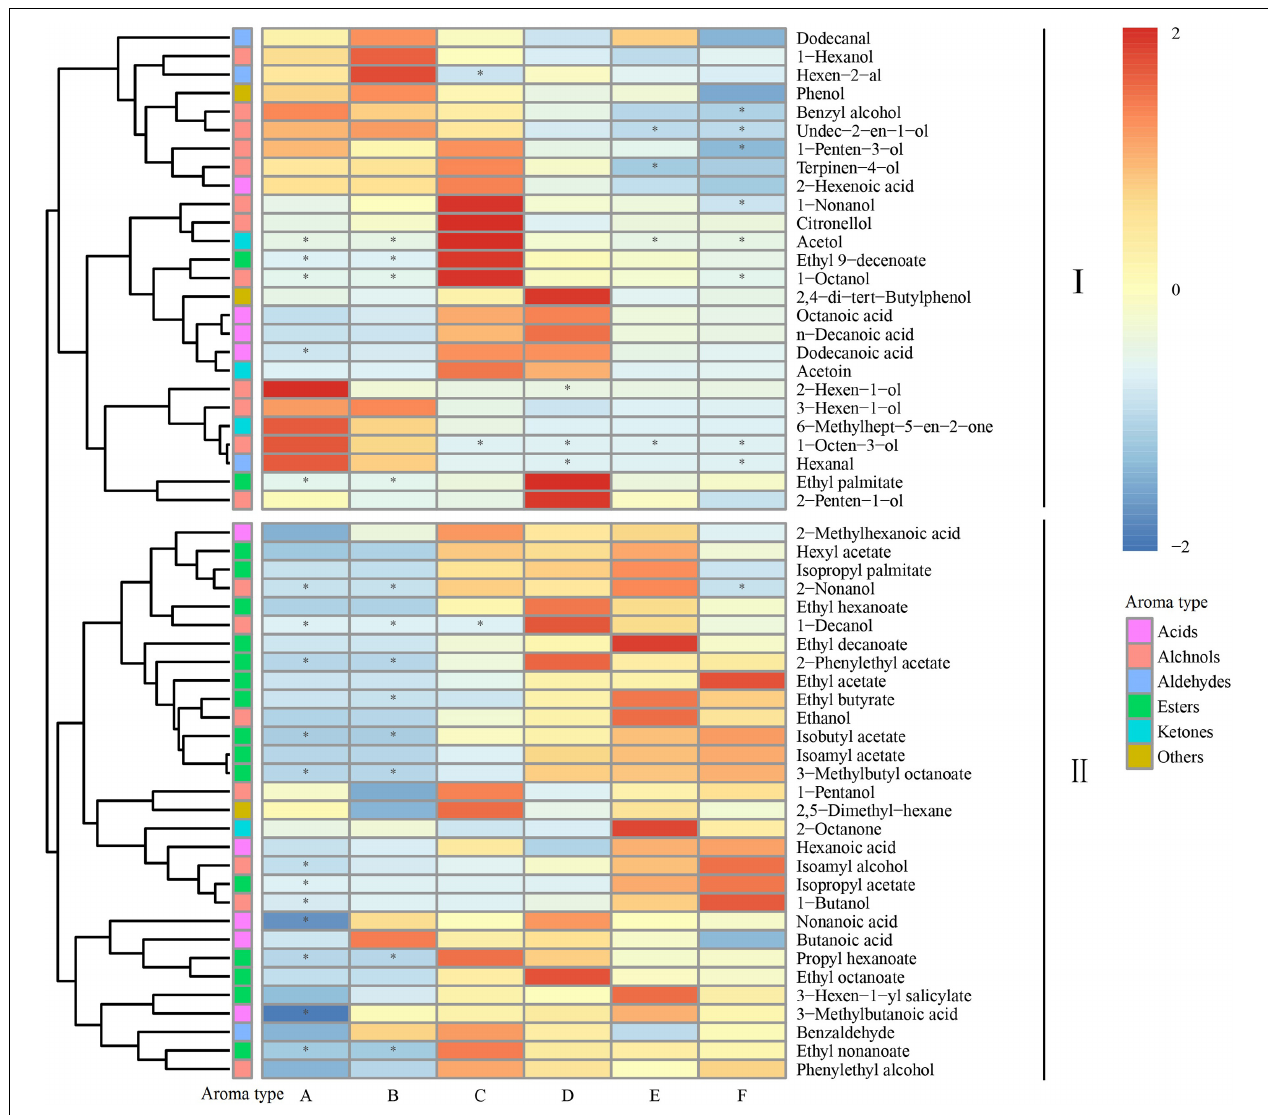
FIGURE 2 | Heatmap cluster analysis of the volatile components during the fermentation. The asterisk indicates the substance with P < 0.05. Samples collected on fermentation days 0, 1, 4, 7, 11, and 14, respectively (for interpretation of the references to color in this figure legend, the reader is referred to the Web version of this